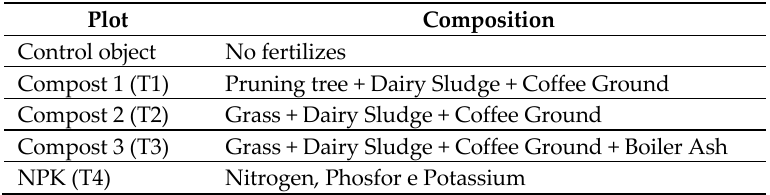
Table 1. Plots and compositions.